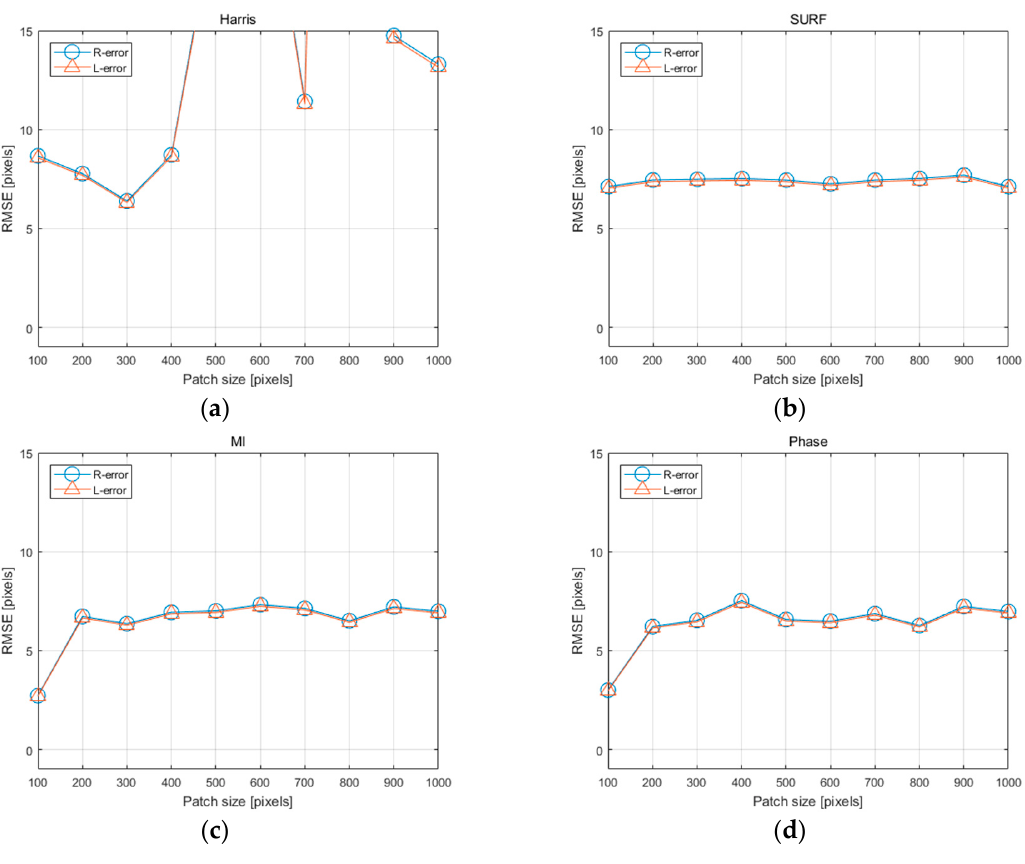
Figure 14. Reprojection errors (along-track Kompsat-3 original—before adjustment): ( a ) HARRIS– FREAK ( b ) SURF, ( c ) MI, and ( d ) PC.